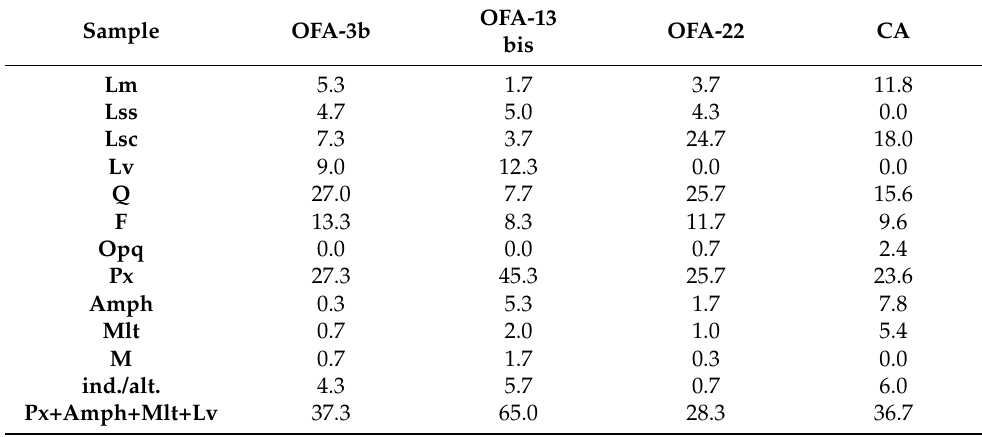
Table 2. Modal composition of the sands.